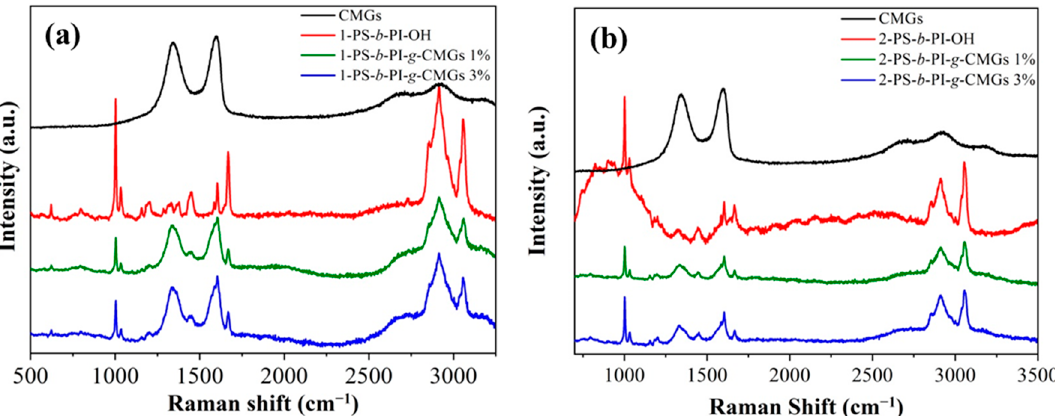
Figure 1. Raman spectra corresponding to ( a ) CMGs (black color), diblock precursor of the 1-PS- b -PI-OH type (red color), the final nanocomposites 1-PS- b -PI- g -CMGs-1% (green color), and 1-PS- b -PI- g -CMGs-3% (blue color); and ( b ) CMGs (black color), diblock precursor of the 2-PS- b -PI-OH type (red color), the final nanocomposites 2-PS- b -PI- g -CMGs-1% (green color), and 2-PS- b -PI- g -CMGs-3% (blue color).